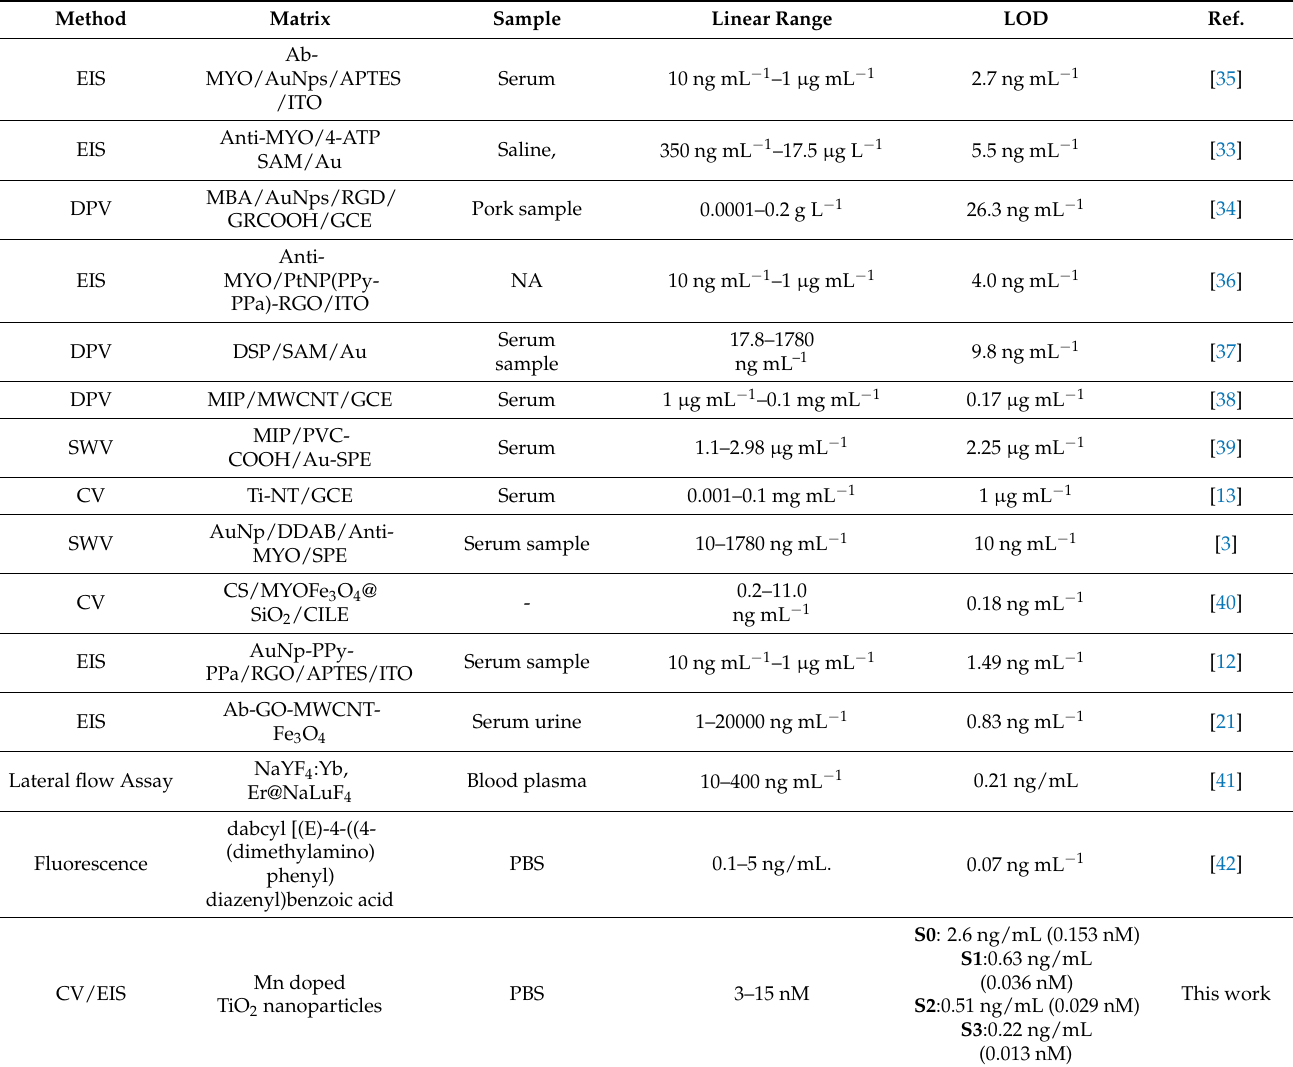
Table 2. Comparison of the sensing properties of fabricated Mn-doped TiO2 nanoparticles biosensor with other reported biosensors.